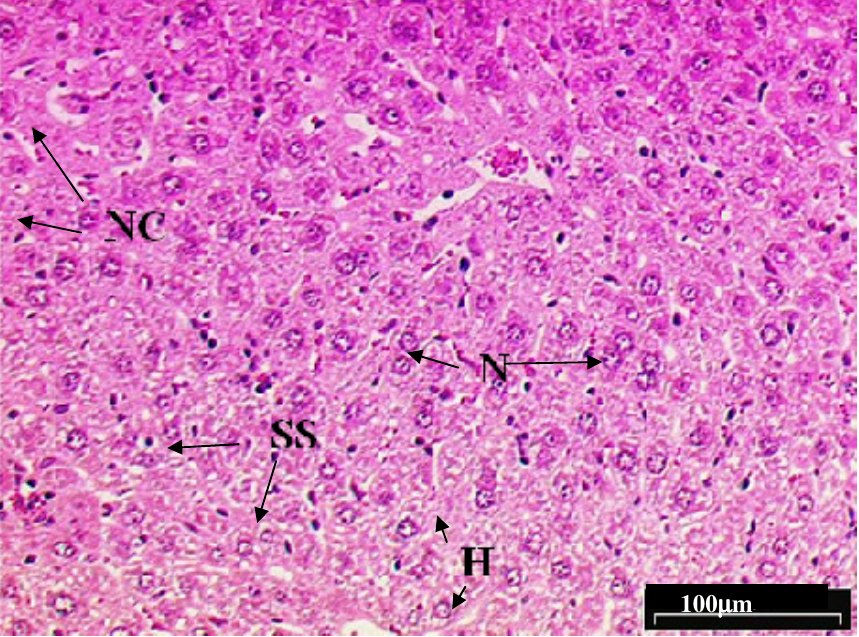
Figure 3. Light microphotographs of haematoxylin and eosin stained sections of the formalin fixed liver cell of mice exposed to paracetamol. Liver cells of Group II mice (exposed to paracetamol) revealed extensive fatty changes, characterized by the disruption of the lattice nature of the hepatocyte, damaged hepatic sinusoids and necrosis. Presences of reticular sides are visible and nucleuses of two to three are joined together. (H, hepatocytes; N, nucleus; SS, sinusoid; NC,